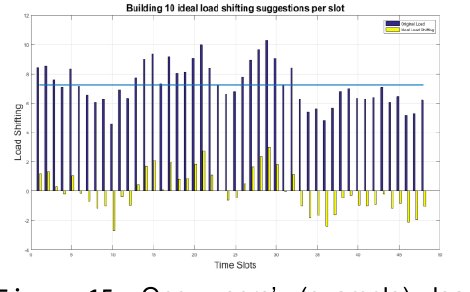
Figure 15. One users’ (example) load shifting suggestions per time slot Different company charges in different